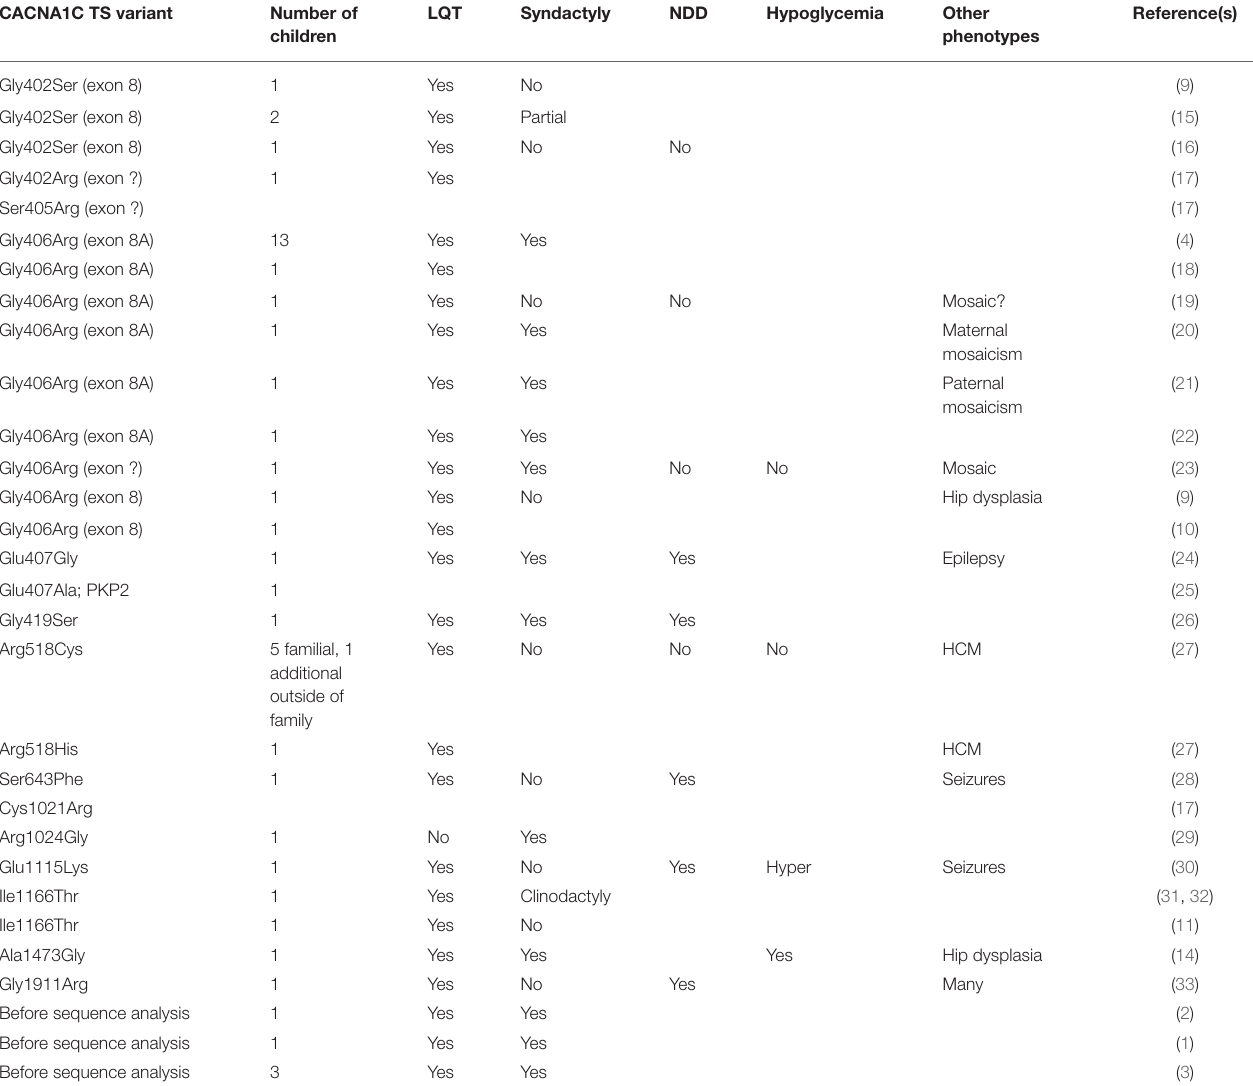
TABLE 1 | CACNA1C variants causative of Timothy syndrome. CACNA1C TS